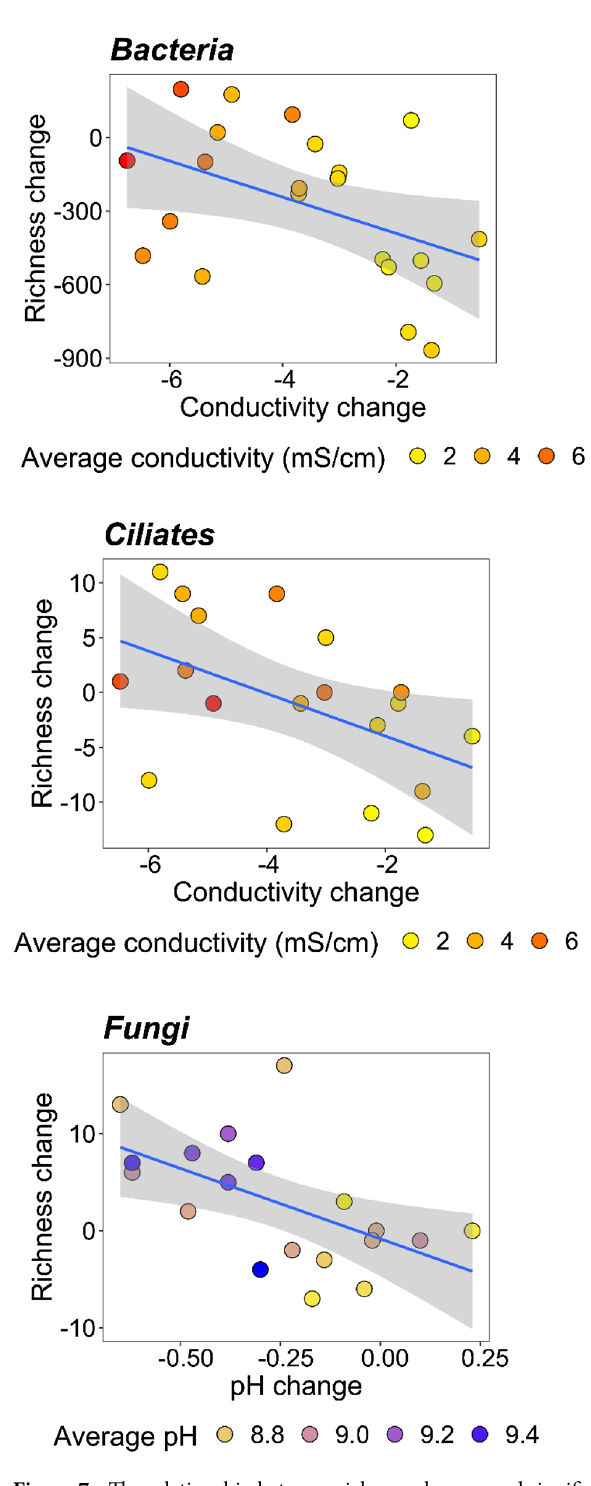
Figure 7. The relationship between richness changes and significant environmental variable changes (p <